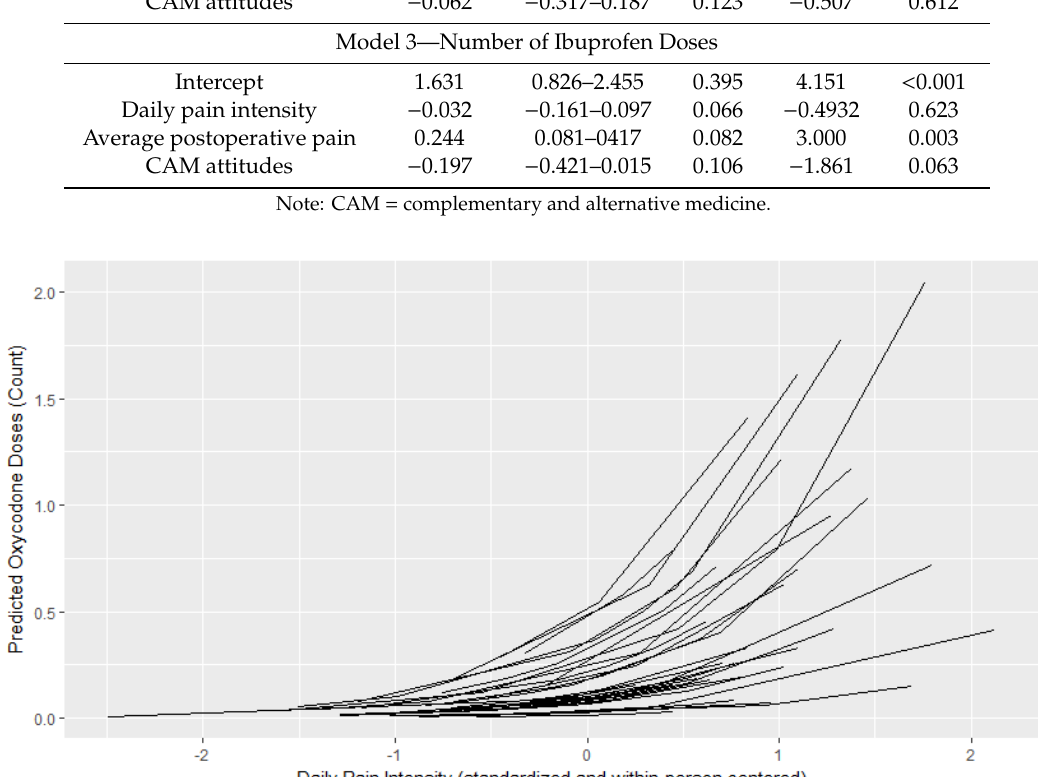
Figure 2. Within-person relationship between a child’s daily pain intensity and predicted acetaminophen doses administered. Daily pain intensity is within-person centered where a higher score indicates greater pain intensity on a given day compared to a child’s average across the postoperative period.